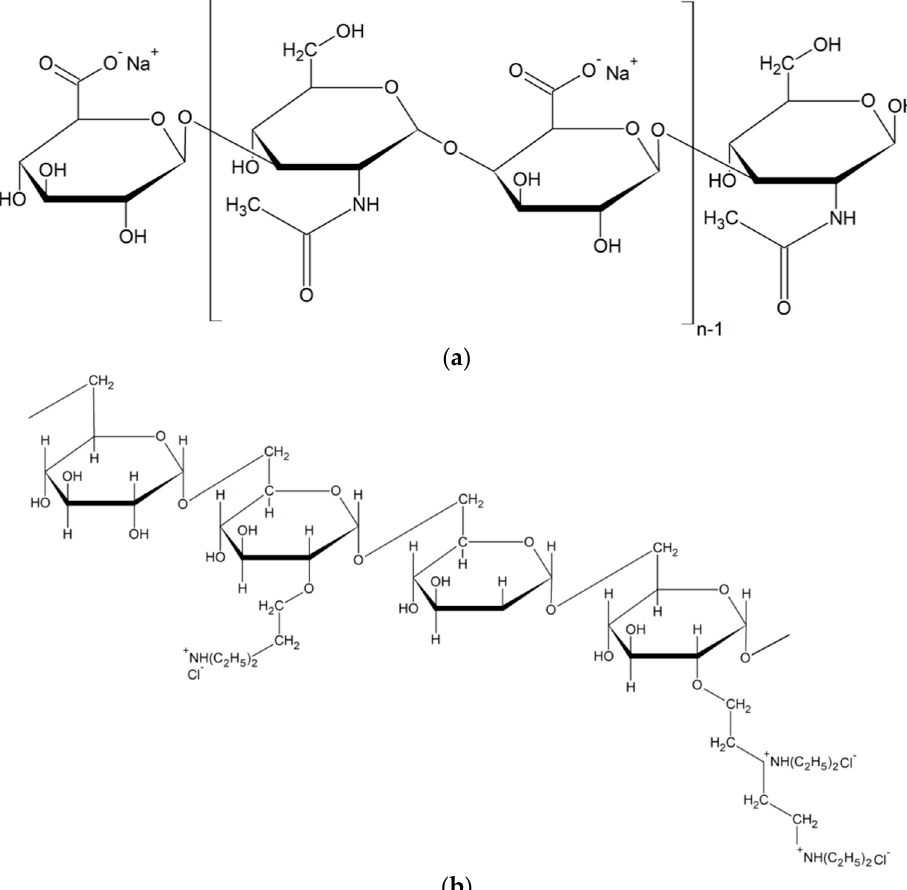
Figure 2. (a) Structure of sodium hyaluronate; ( b ) structure of modified dextran ( a ) Structure of sodium hyaluronate; ( b ) structure of modified dextran (DEAE—diethylaminoethyldextran hydrochoride). (DEAE—diethylaminoethyldextran